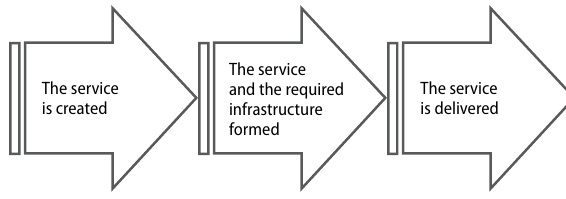
fig. 2. a traditional model for work done by state and